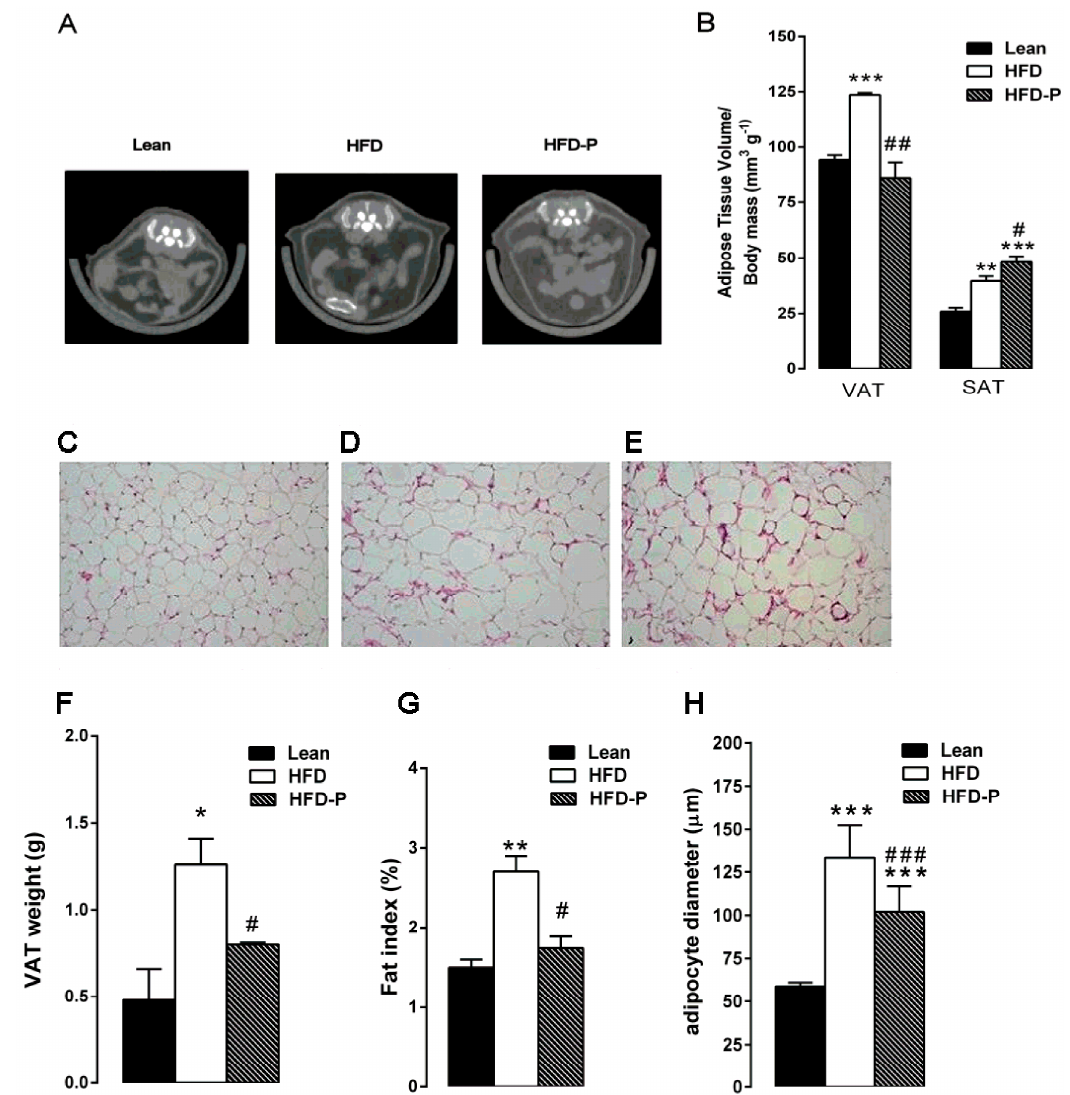
Figure 3. Pistachio consumption and HFD-induced adipose tissue alterations. Pistachio diet prevents visceral fat accumulation. Transverse micro-computed tomography (micro-CT) images of the abdomen ( A ) and visceral adipose tissue (VAT) and subcutaneous adipose tissue (SAT) volume ( B ) in lean, HFD, and HFD-P mice. Histological cross-sections of VAT from lean ( C ), HFD ( D ), and HFD-P mice ( E ). Hematoxylin and eosin stain. Original magnification: × 200. VAT weight (F), VAT weight normalized to body weight (fat index) ( G ), and adipocyte diameter ( H ) in lean, HFD, and HFD-P mice. Data are the means ± S.E.M. ( n = 8/group). Asterisk denotes significant difference compared with the lean group (* p < 0.05; ** p < 0.01; *** p < 0.001); hash denotes significant difference compared with the HFD group ( # p < 0.05; ## p < 0.01; ### p < 0.001;).